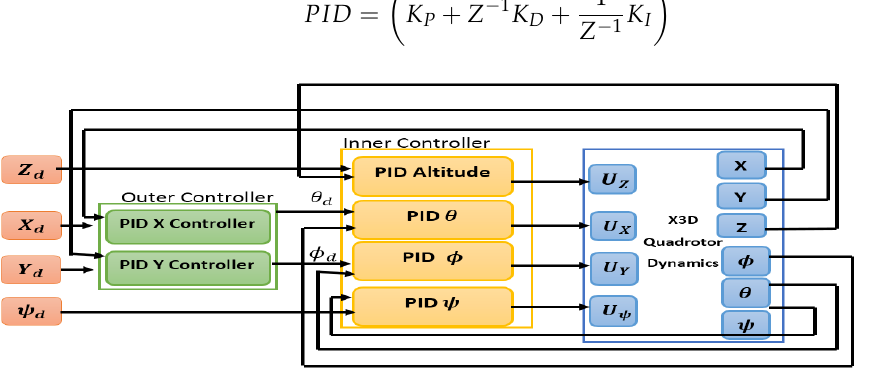
Figure 5. X3D Quadrotor PID Controllers. Table 3. Parametric Gain values of each PID Controllers.